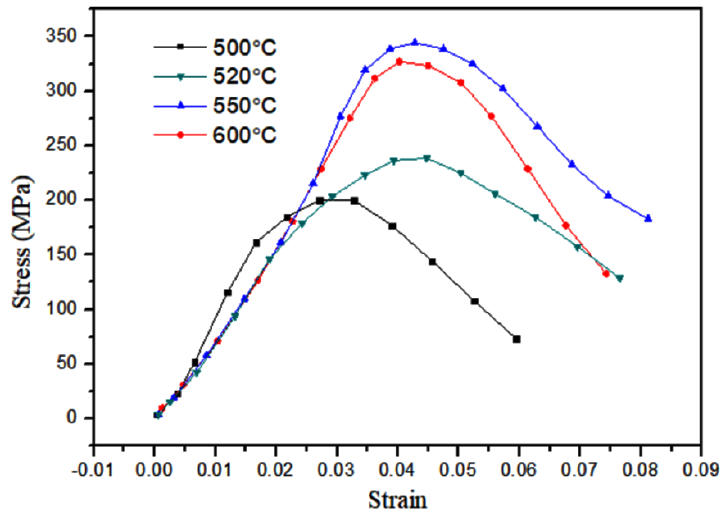
Figure 10. Dynamic compression curves of the Fe/Al composites with different maximum sintering temperatures at a strain rate of 5500 s − 1 .